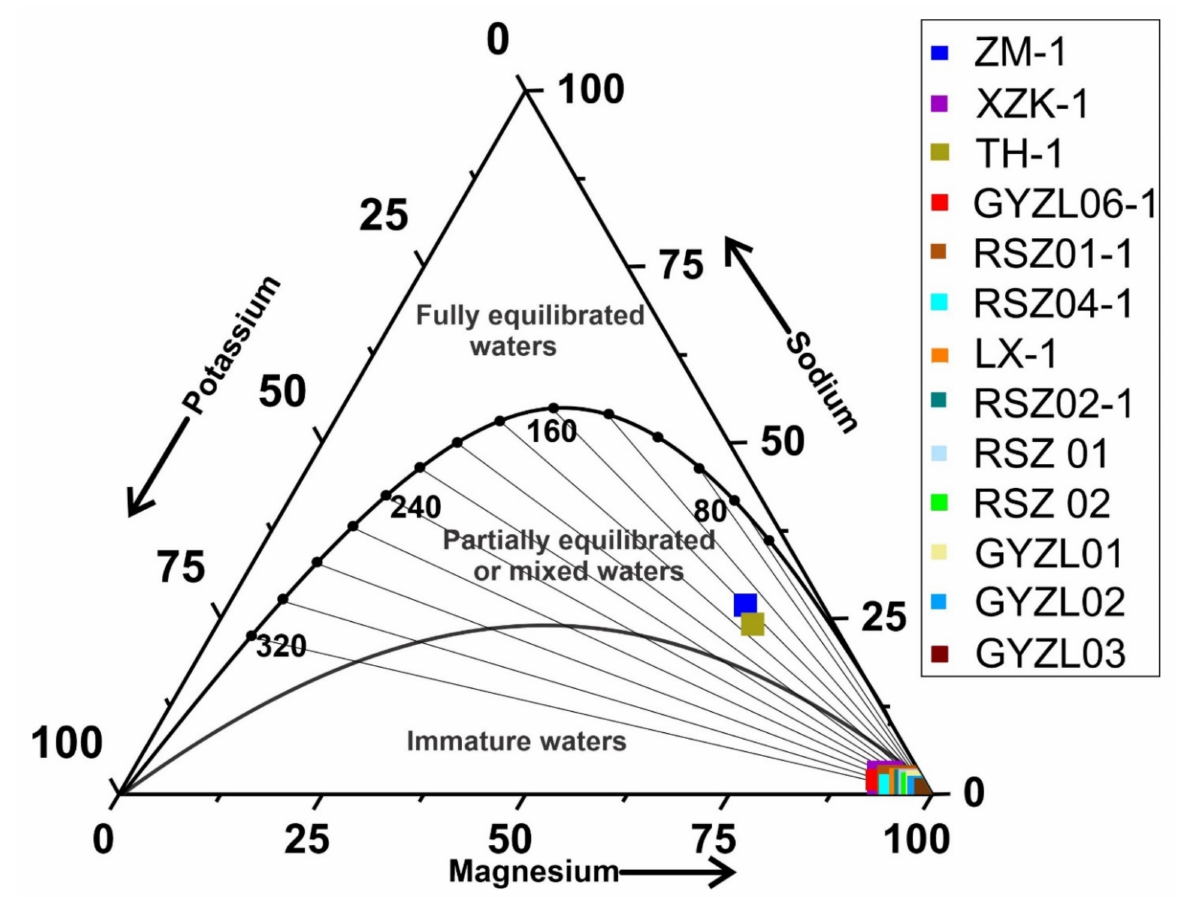
Figure 9. Na/1000-K/100/Mg 1/2 of thermal and non-thermal waters. All the water samples except (ZM-1 an-TH-1) are “immature waters”, evaluating the mixing with cold ground waters.